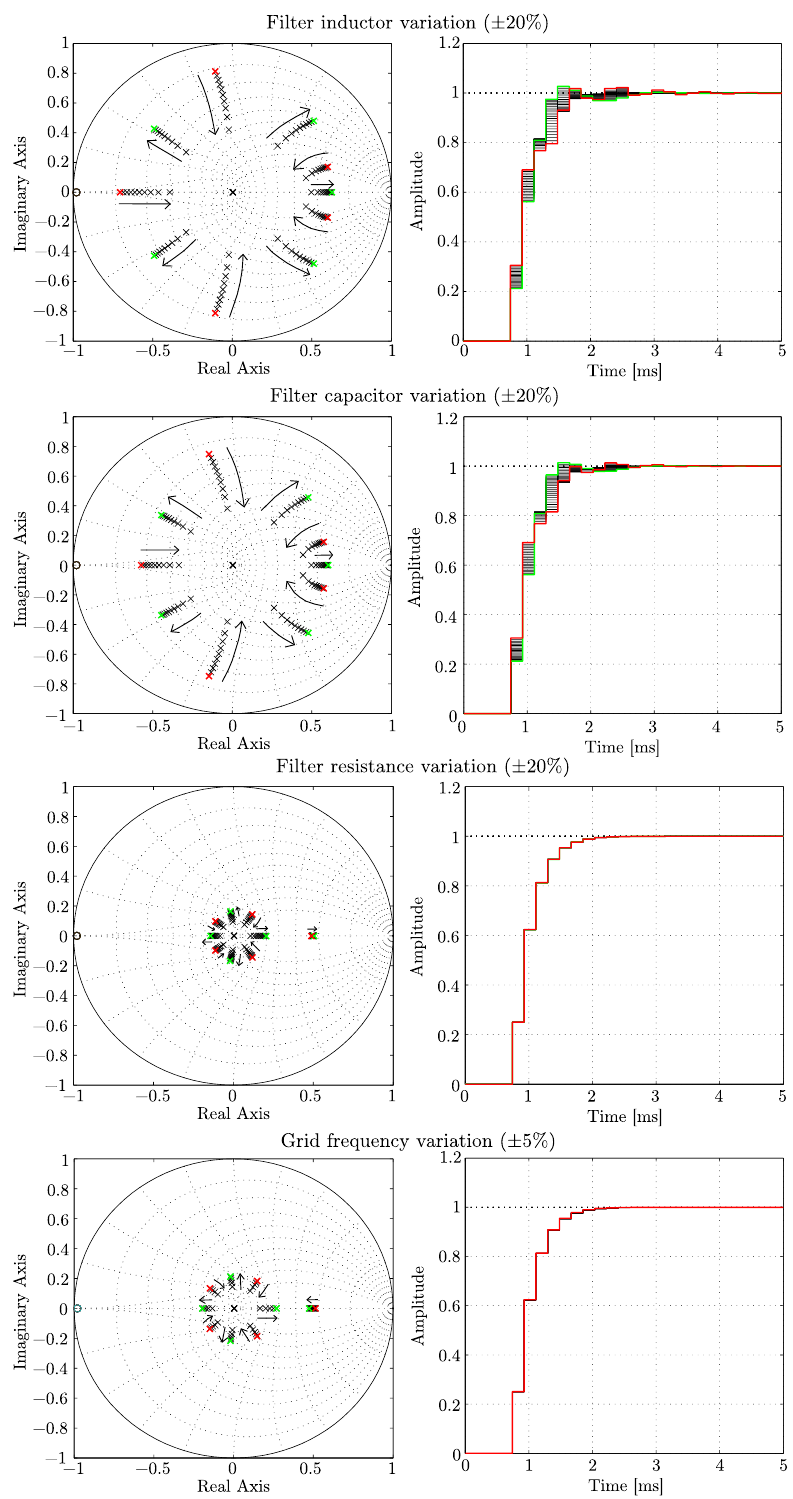
Figure 12. Pole-zero analysis of the closed-loop control system when the value of the hardware elements is modified. From top to bottom, filter inductor, filter capacitor, filter resistance, and grid frequency. (red) Initial value of (green) final value. Arrows indicate the increasing